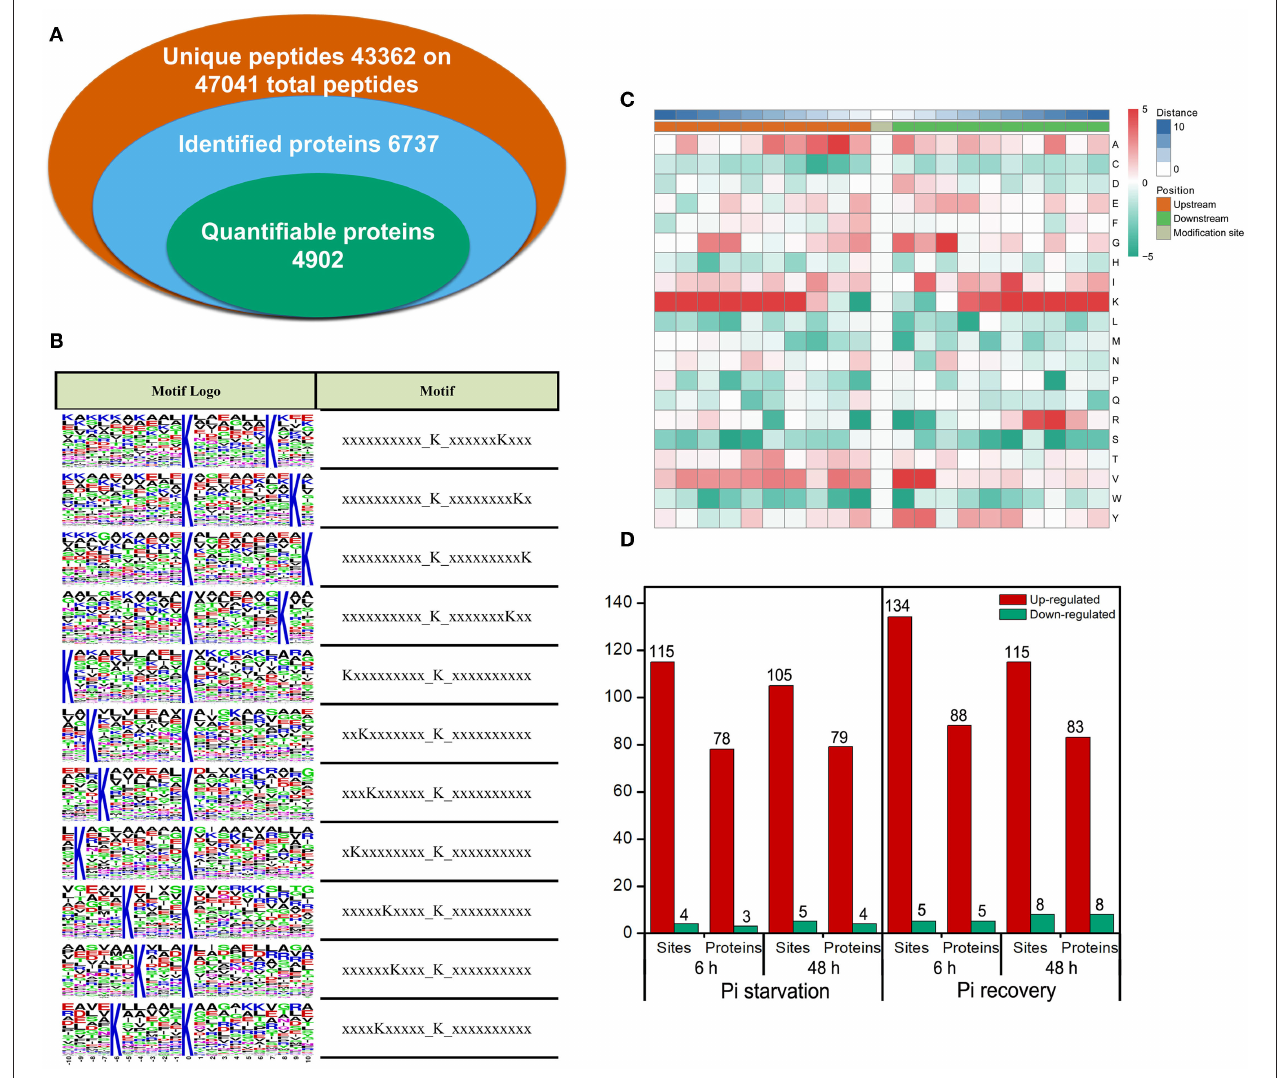
FIGURE 4 | Properties of the succinylated peptides in barley roots. (A) Summary of the succinylome identified and quantified; (B) motif analysis of identified succinylated sequence by Motif-X software. The motifs with high significance ( P < 0.000001) are shown; (C) position-specific amino acid composition around the succinylation sites. The –log10 (Fisher’s exact test P -value) for every amino acid in each position (from − 10 to + 10) is shown; (D) overview of the differentially succinylated sites and proteins (fold change > 1.5, P <